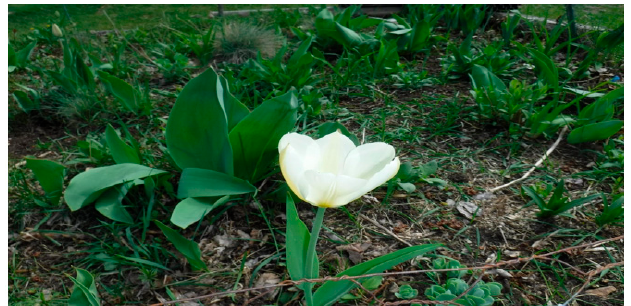
Figure 11. A photo of a garden.